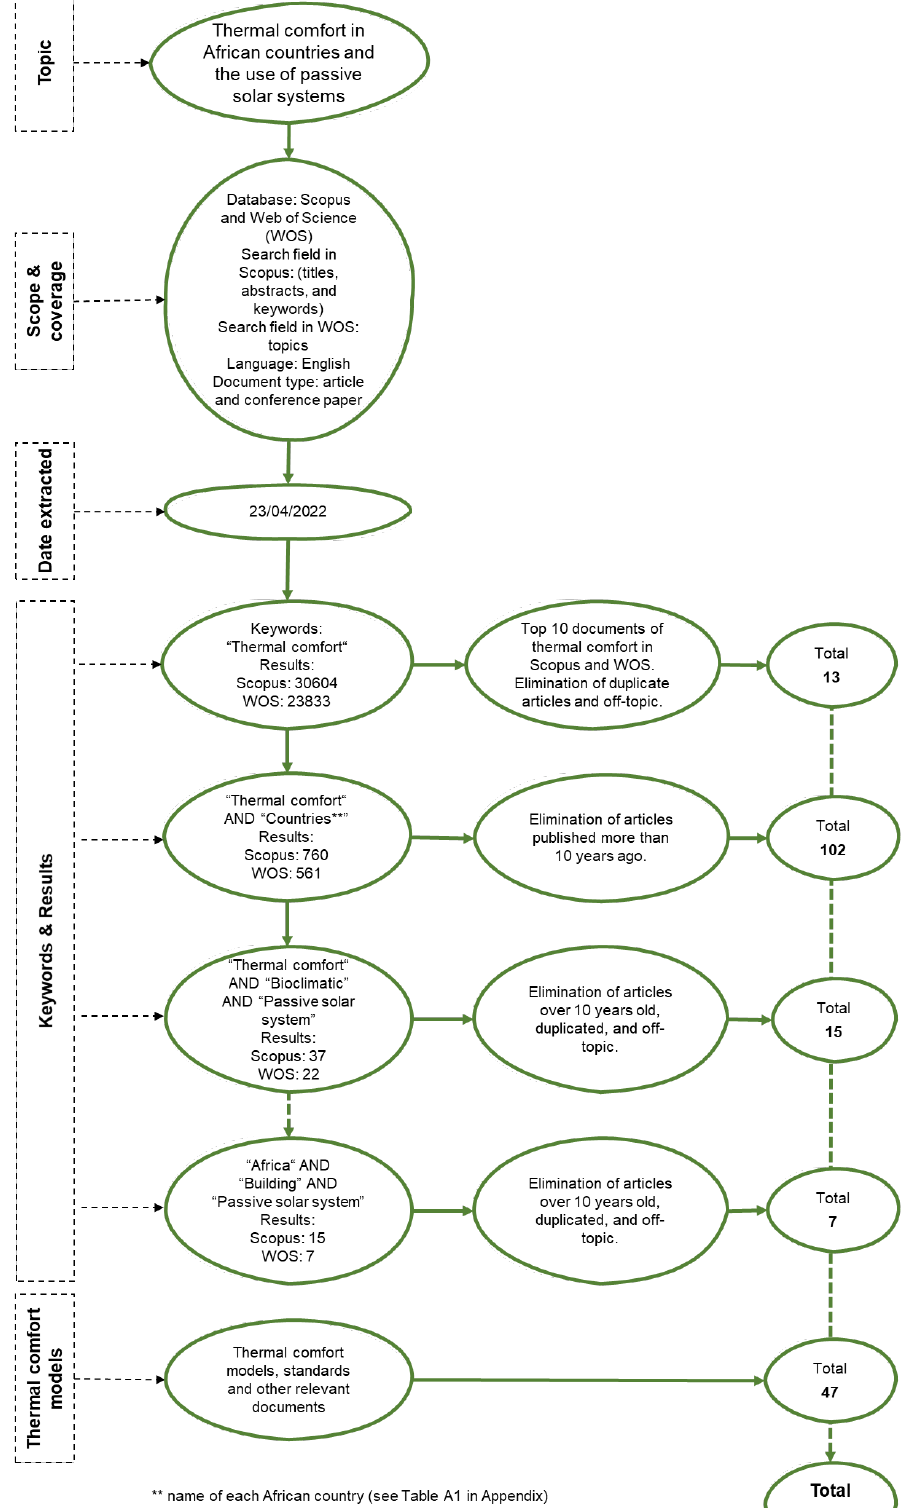
Figure 1. Literature acquisition method in the review